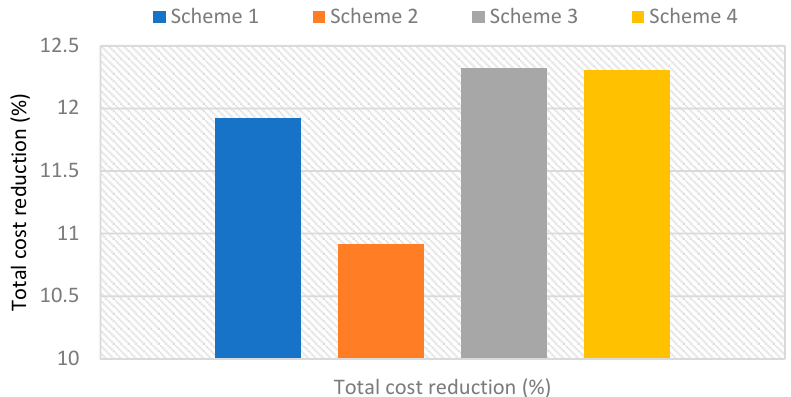
Figure 8. Comparison of total planning cost of both case studies.